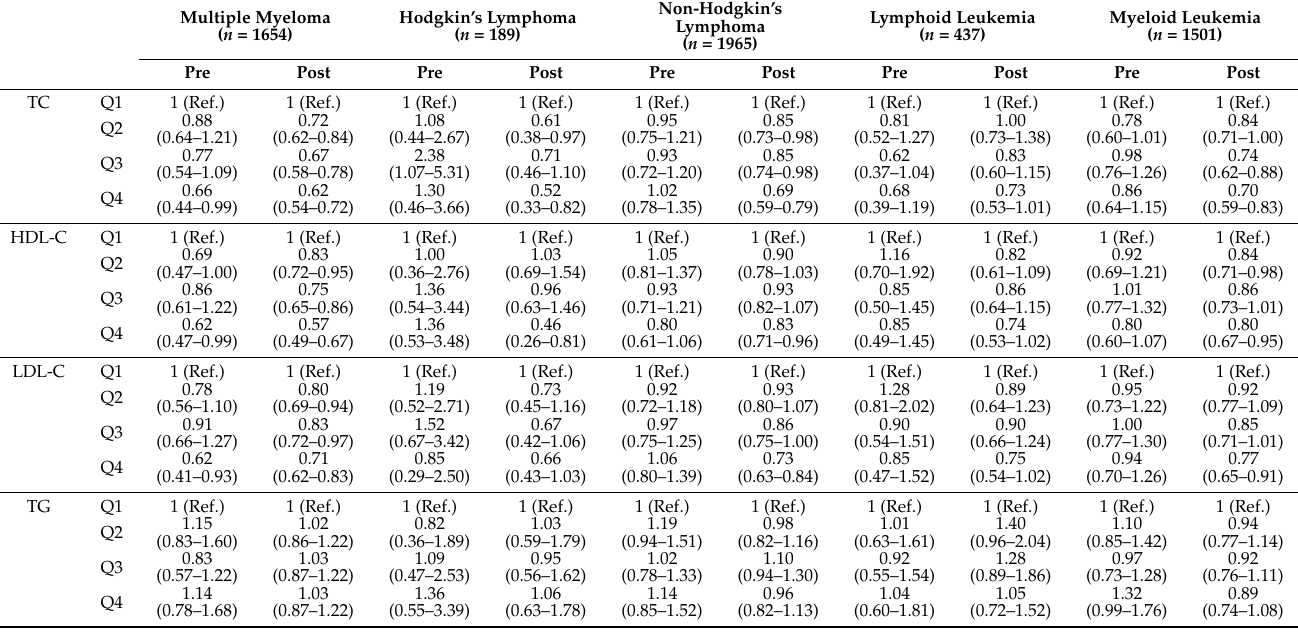
Table 3. Risk of subtypes of hematologic malignancy by quartile of each lipid profile.